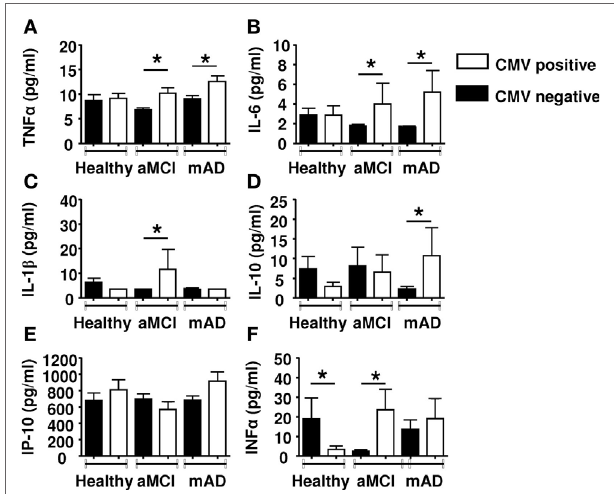
FigUre 6 | Quantification of cytokine concentrations in sera according to CMV serostatus. (a) TNF α . (B) IL-6. (c) IL-1 β . (D) Il-10. (e) IP-10. (F) IFN α . Each group (healthy controls, amnestic mild cognitive impairment [aMCI], and mild AD [mAD]) was composed of at least 10 independent subjects with determinations made in triplicate. Cytokine quantification was done using the Luminex technology. Data are shown as the mean ± SEM. The asterisks (*) corresponds to p < 0.01. Empty rectangle, CMV-positive cells, filled rectangle, CMV-negative cells.